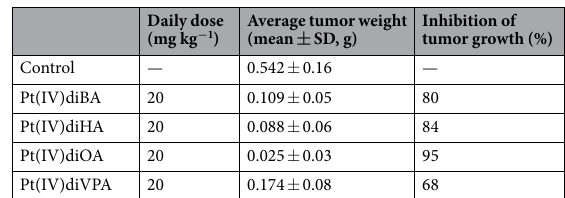
Table 4. The in vivo antitumor activity of Pt(IV) prodrugs and cisplatin evaluated in a model of solid tumor a . a Lewis lung carcinoma (LLC) was implanted i.m. (2 × 10 6 cells inoculum) into the right hind leg of 8-week old C57BL mice (24 ± 3 g body weight). Chemotherapy was delayed until the tumor became visible (day 7). Day 7–14: animals received daily orally 20 mg kg − 1 of Pt(IV) complexes as well as daily i.p. 1.5 mg kg − 1 of cisplatin. At day 15 animals were sacrificed, legs amputated at the proximal end of the femur, and the inhibition of tumor growth was determined as the difference in weight of the tumor-bearing leg and the healthy leg expressed as % referred to the control animals. The values are the means ± SD of not less than three